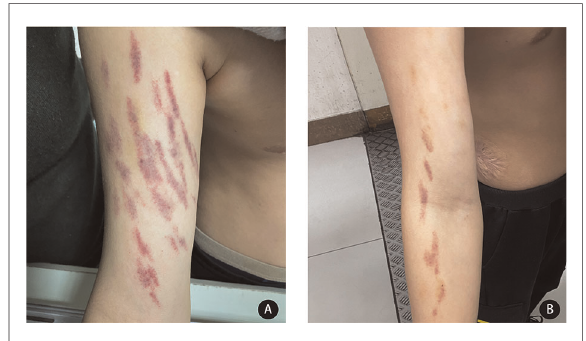
FIGURE 1 Striking linear symmetric purpuric streaks on the proximal extensor sides of both arms. The purpura was not palpable. ( A) Purpura formed suddenly, ( B) purpura 2 days after